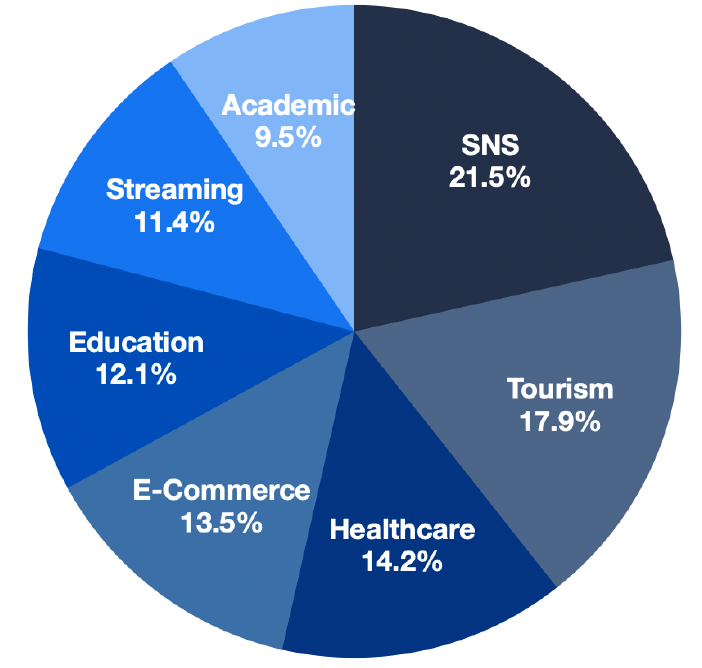
Figure 30. Distribution of seven recommendation system fields from 2010 to 2021.